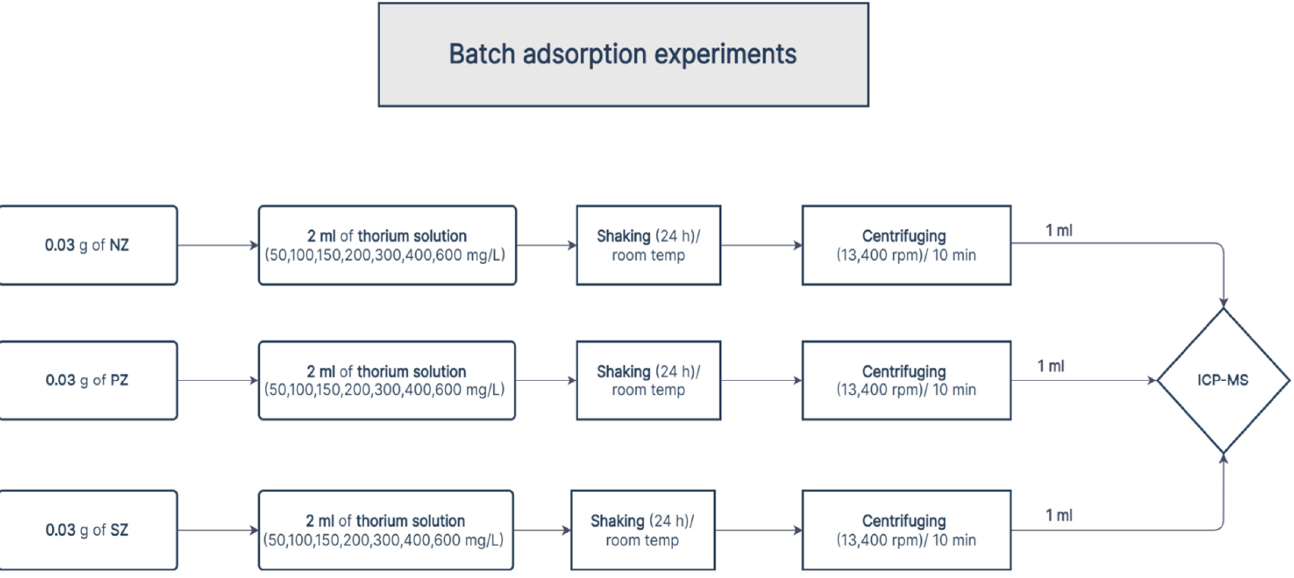
Figure 2. The schematic illustration of the batch adsorption experiments.